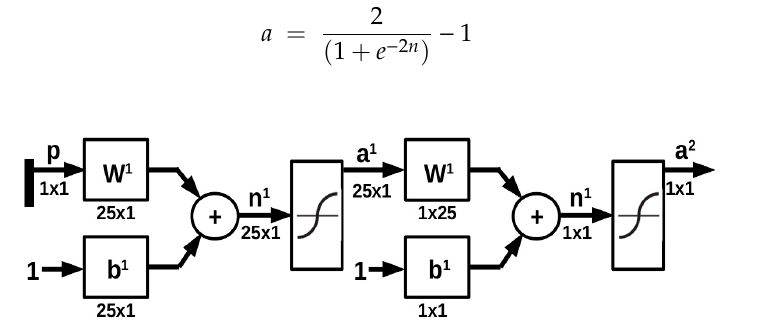
Figure 2. Artificial neural networks ( ANN) feedforward.